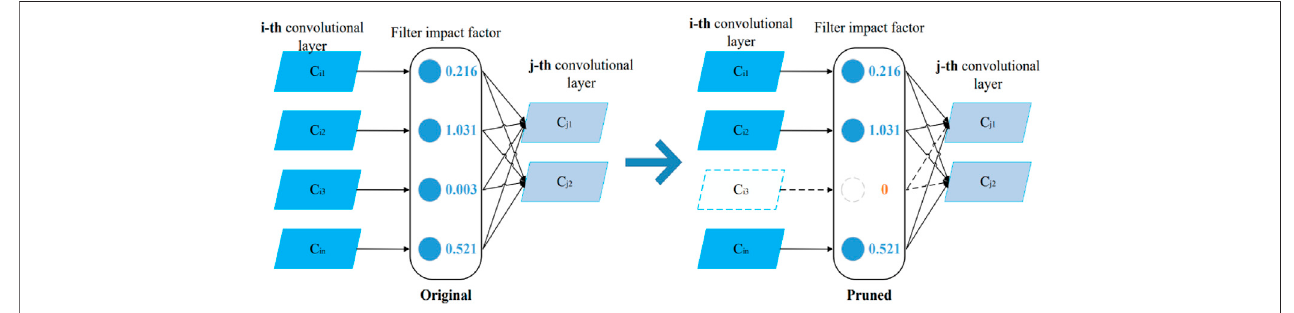
FIGURE 2 | Structured pruning